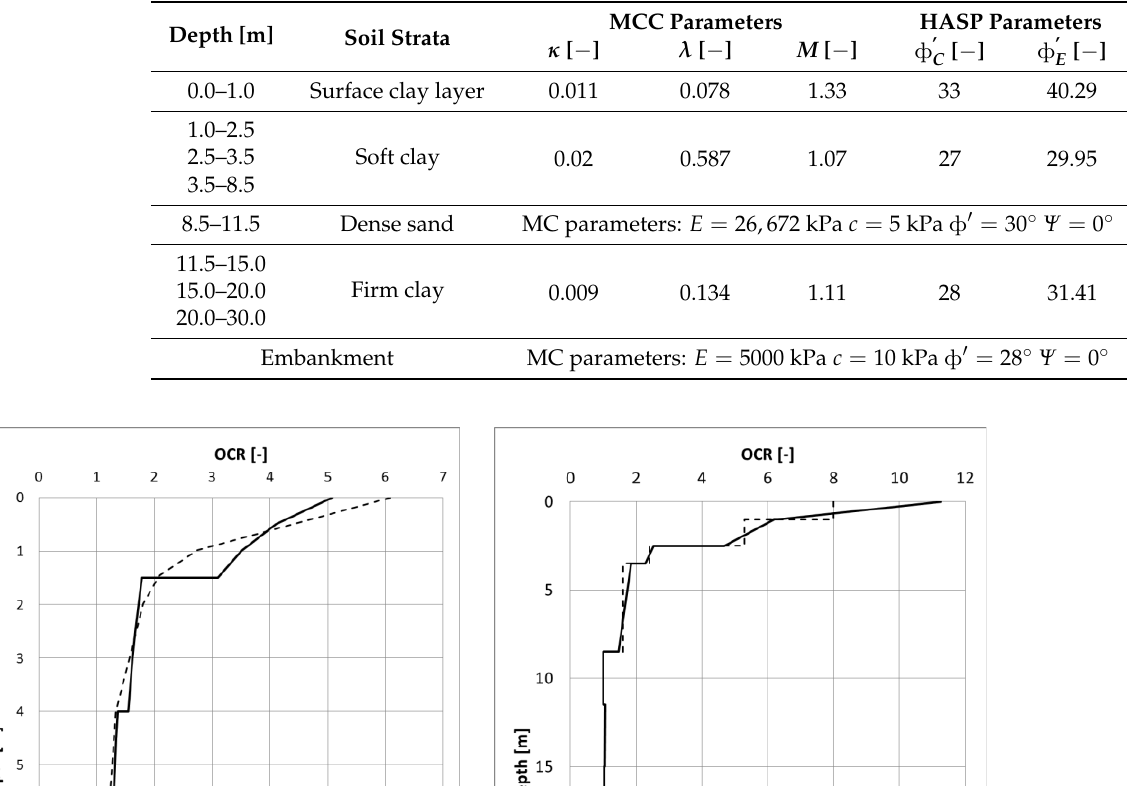
Table 4. Soil model parameters for Embankment B.